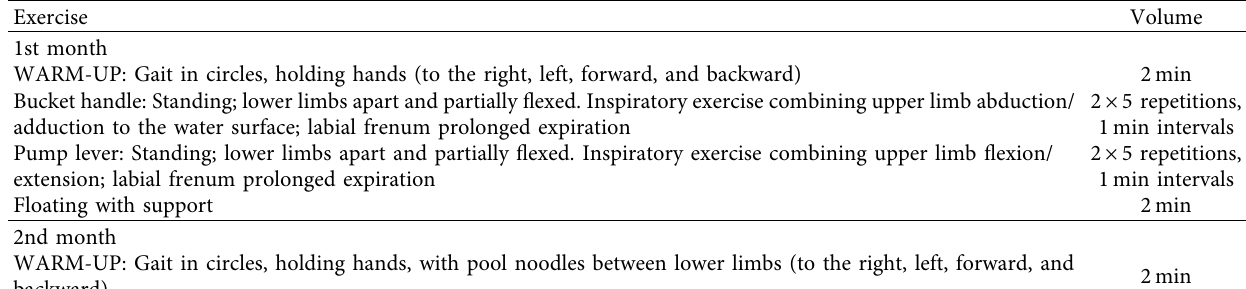
Figure 2: Composition for inference of ventilatory disorders. Table 1: Phase of